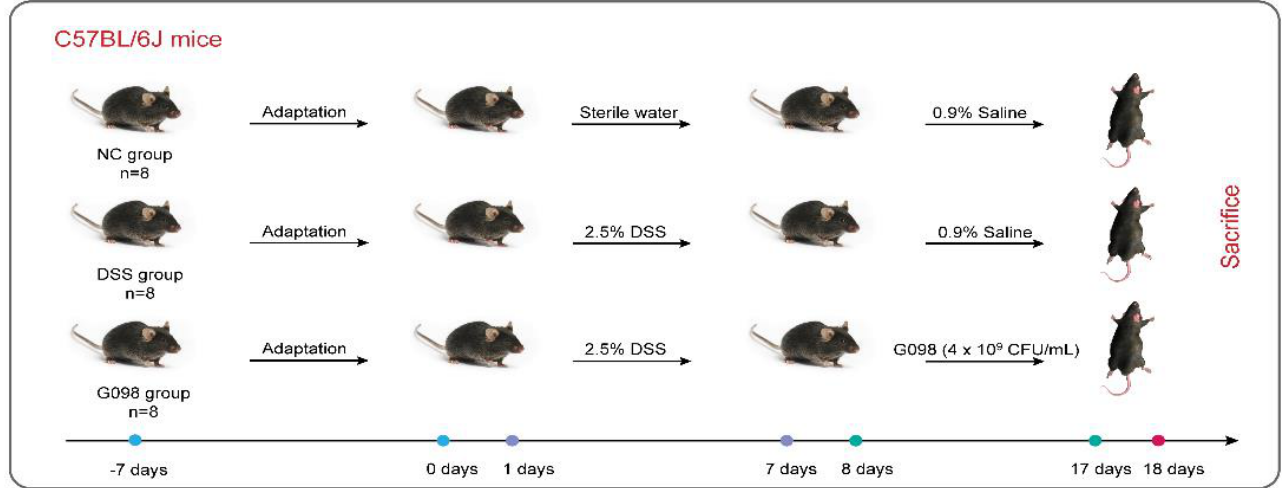
Figure 1. Experimental design. “NC”, “DSS”, and “G098” groups represent normal control, dextran sodium sulfate-induced, and Lactobacillus gasseri G098 groups, respectively.